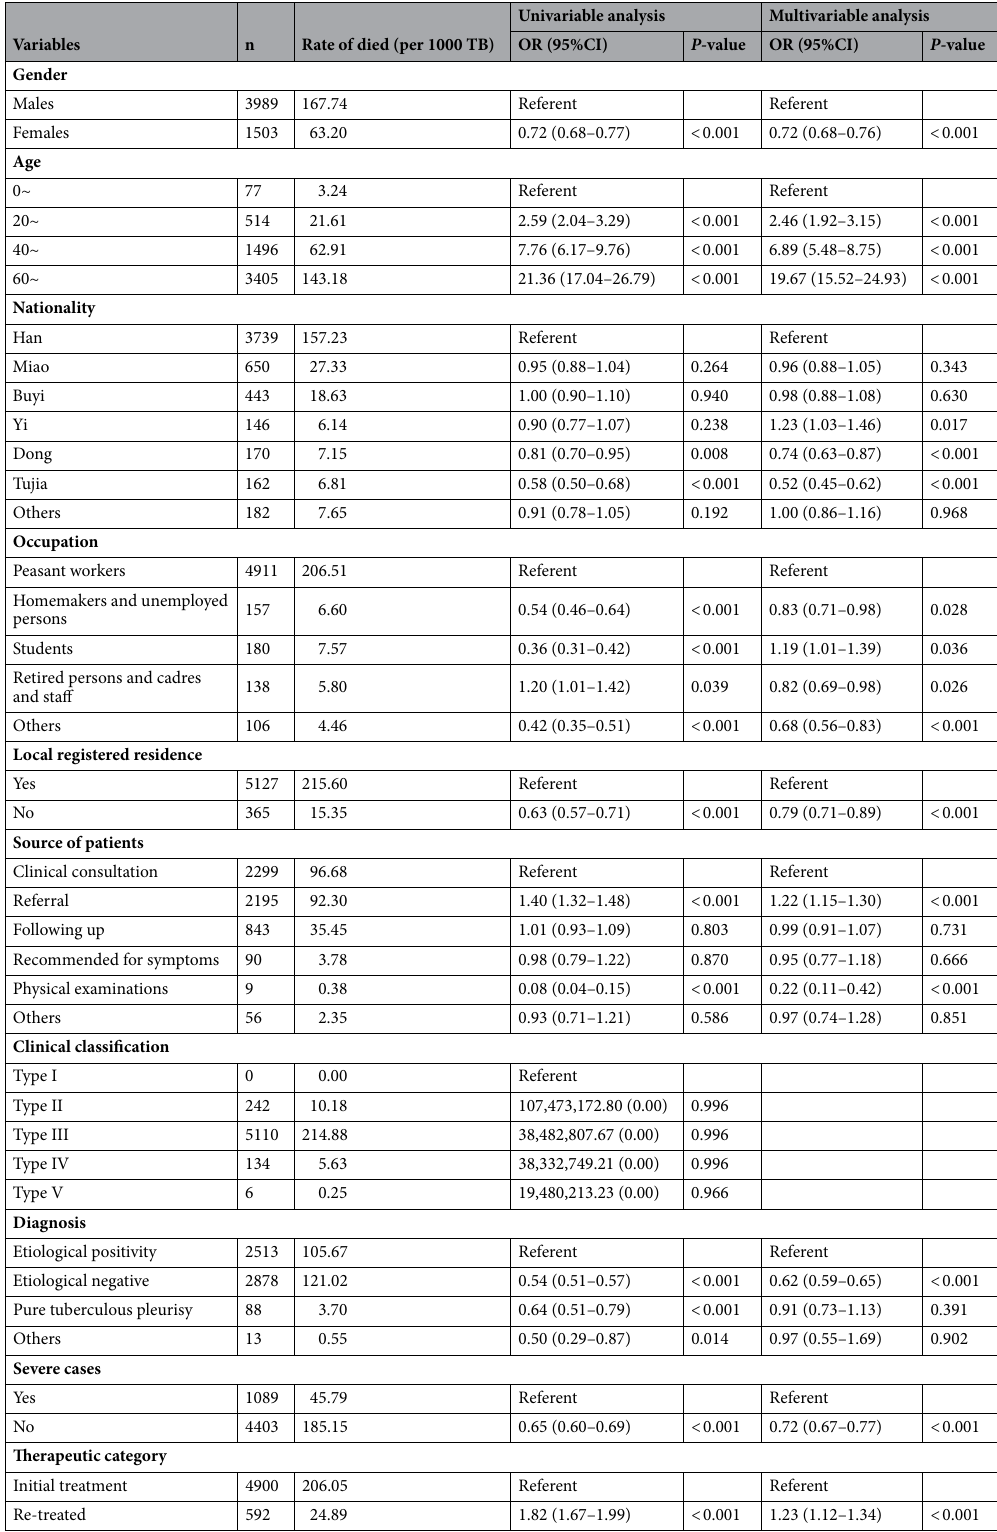
Table 4. Results of risk factors analysis of died in TB